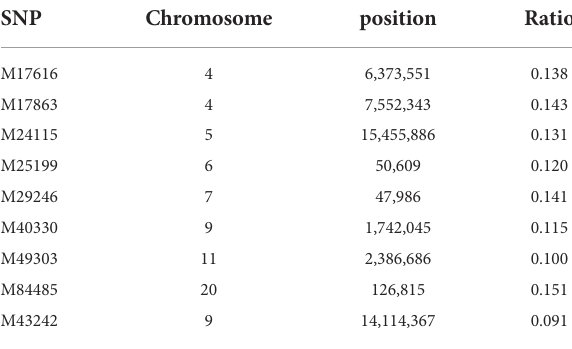
TABLE 3 SNPs associated with hypermelanosis in Chinese tongue sole.